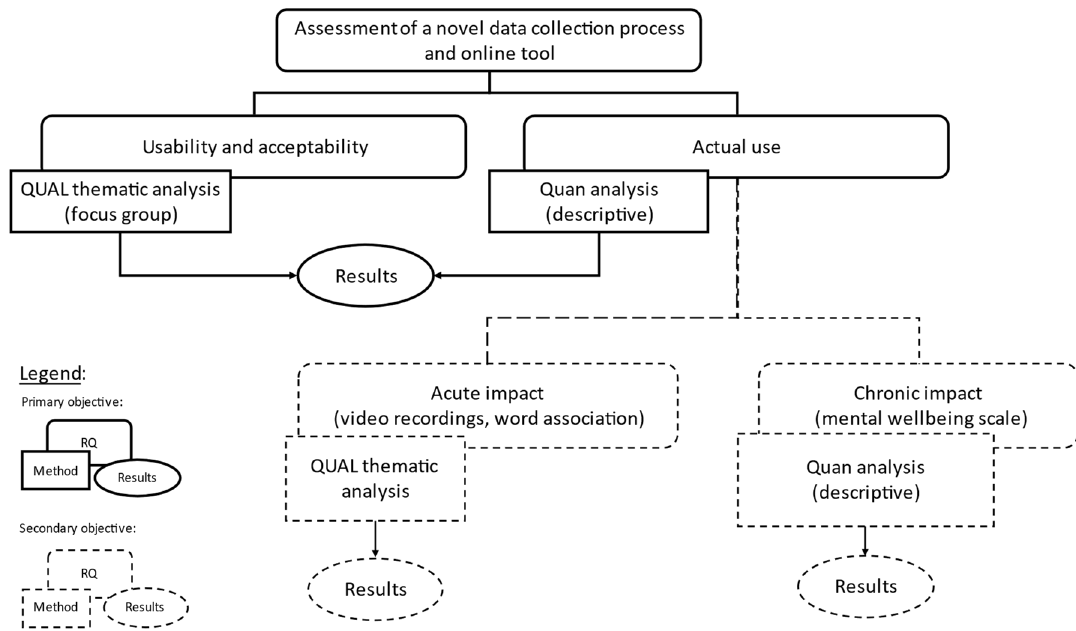
Figure 1. Research questions (RQ) and methods.